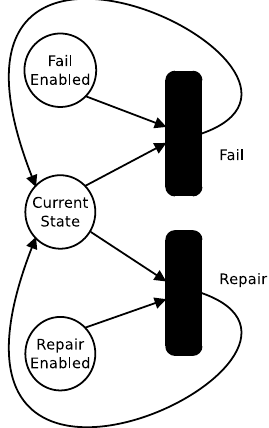
Figure 2: Graphical representation of the state variables and actions that model the failure and repair behavior of a component. Arcs represent preconditions and effects of an